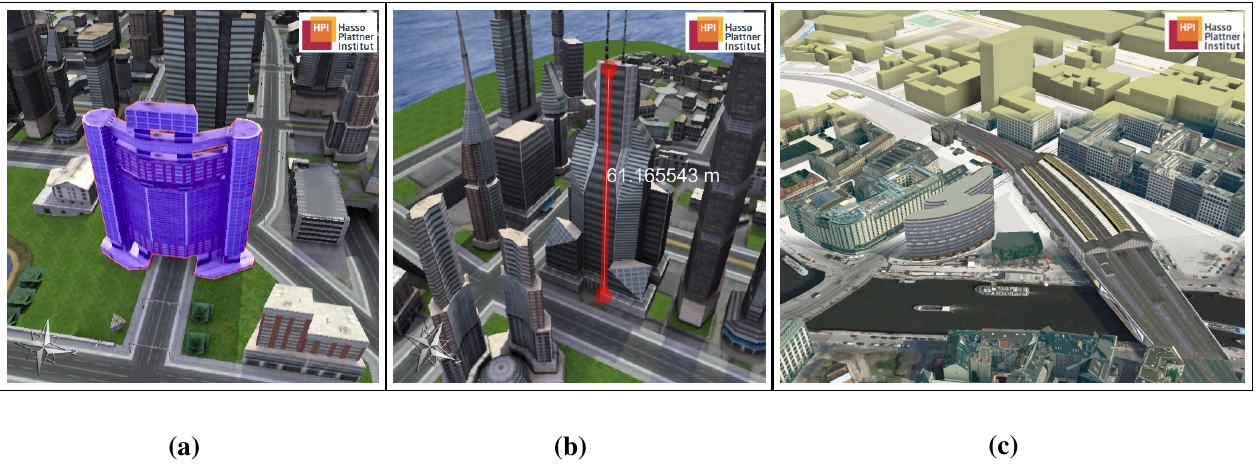
Figure 9. Screenshots of the viewer client of a 3DGeoVS based on SSI derived from the SRA. ( a ) Selecting a feature of a 3D model displayed using a photorealistic style; ( b ) measuring the Euclidean distance between two selected points displayed using a photorealistic style; ( c ) using a style integrating photorealistic and cartography-oriented